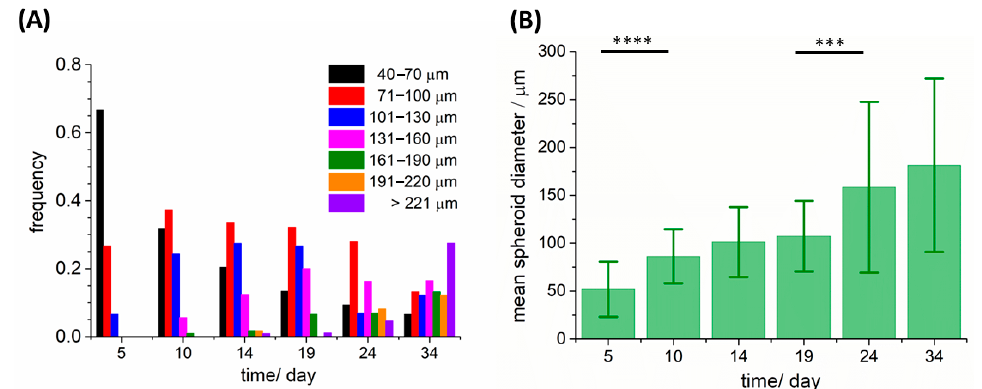
Figure 4. Analyses of HeLa spheroid diameter over several weeks (at day 5, 10, 14, 19, 24, 34). ( A , B ) Frequency distribution of spheroid diameter ( A ) and mean diameter in the spheroid population (( B ), mean ± standard deviation) with increasing culturing time. The number of spheroids at each time point are reported as: day 5, 22 spheroids; day 10, 107 spheroids; day 14, 113 spheroids; day 19, 72 spheroids; day 24, 86 spheroids; day 34, 91 spheroids. Levels of statistical significance are calculated as detailed in Section 2.9 and are indicated as follow: ***, p < 0.001; ****, p < 0.0001.